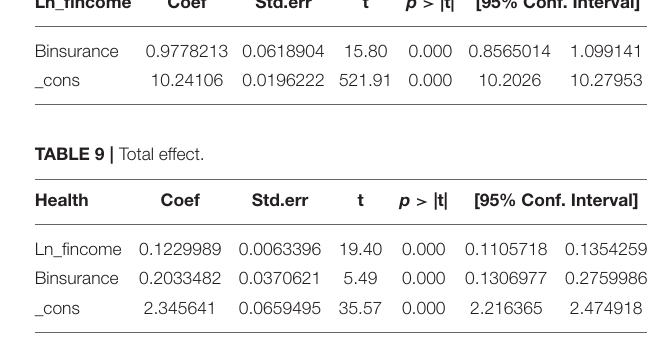
TABLE 6 | Heterogeneity test–urban-rural differences. Variable